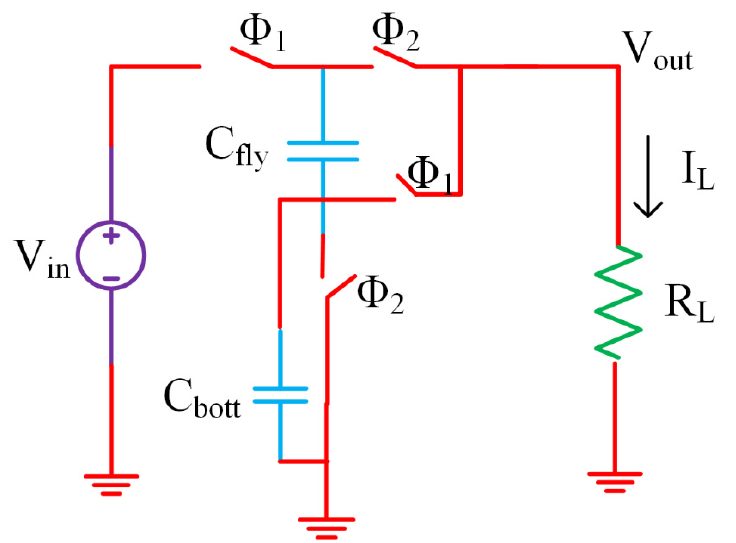
Figure 7. A 2:1 step-down SC DC–DC converter [43]. Reproduced from [43], In Proceedings of the IEEE Symposium VLSI Circuits: